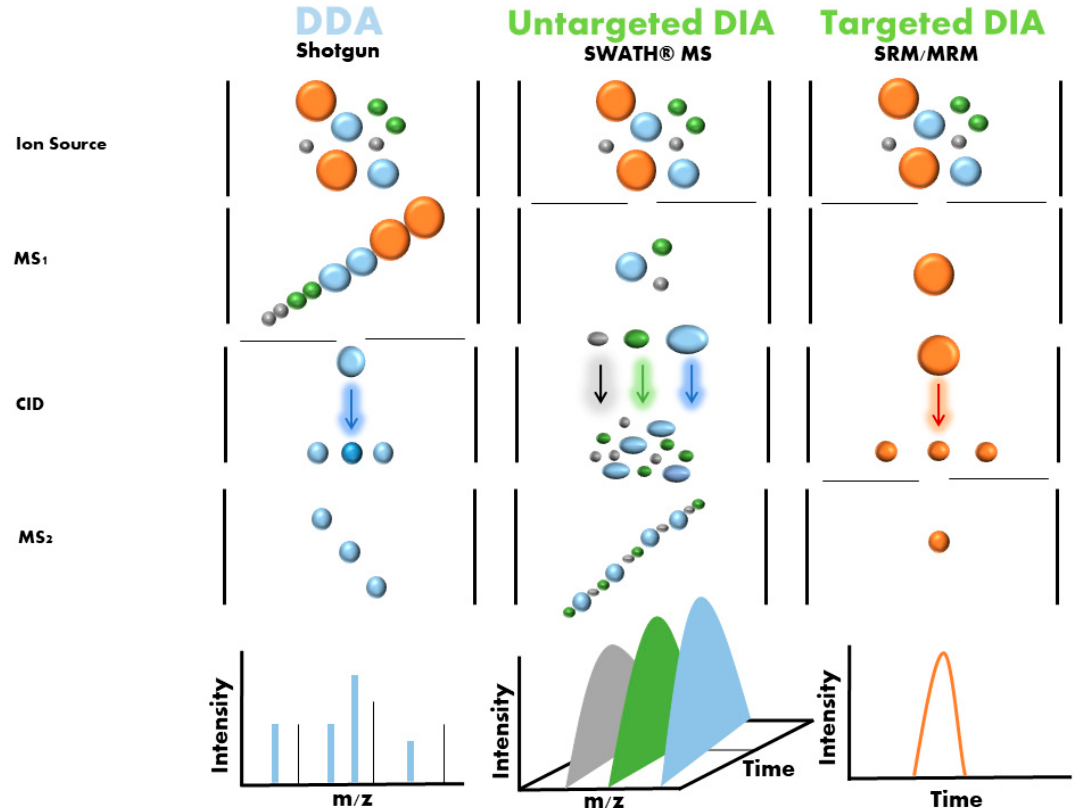
Figure 4. DDA and DIA mode in proteomic analysis. In DDA mode, extracted proteins are digested and directly analyzed by single-shot DDA. The acquired data is searched against a database of known protein sequences and further processed using diverse software tools. In DIA mode, two distinct forms of proteomic analysis can be performed: SWATH-MS (untargeted DIA) and SRM/MRM (targeted DIA). In SWATH-MS extracted proteins are digested and directly analyzed by single-shot analysis in order to generate the spectral library. Once the library is generated, a multi-window running method is applied to individual samples; wide isolation windows span the entire MS1 m/z range and all precursor ions in the library that are found in each isolation window are fragmented in MS2. All proteins found in the library are quantified (untargeted) and all samples are processed using data analysis software to obtain the quantitative data. In MRM and SRM, the precursor ions to be analyzed are fixed (targeted) by the user, and only these are fragmented in